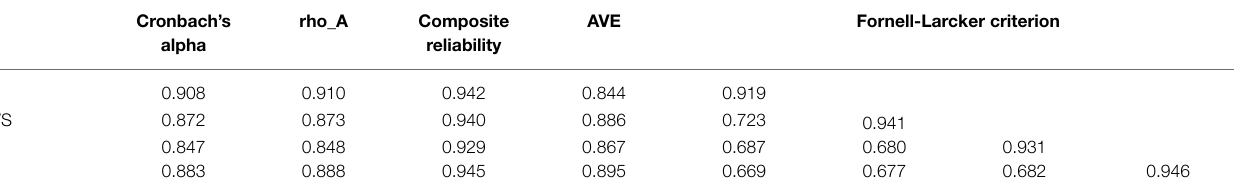
TABLE 9 | Reliability and validity.